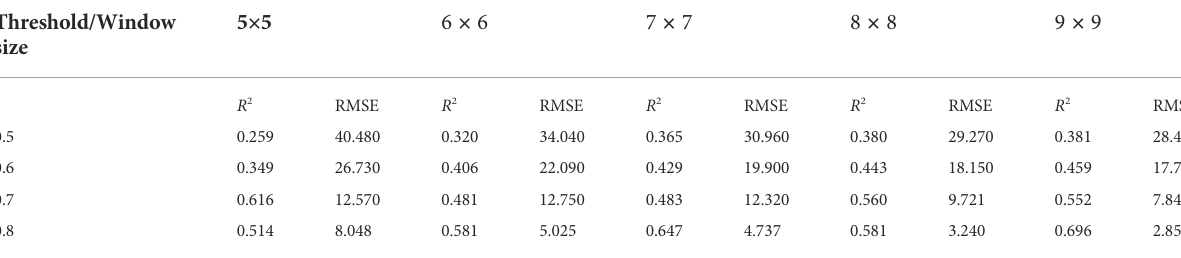
TABLE 5 performance of different sampling window size and threshold at VV channel.